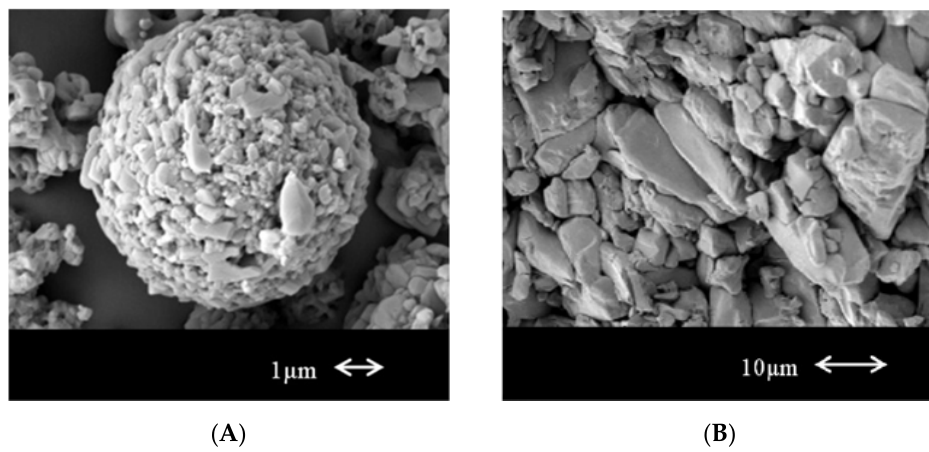
Figure 4. SEM images of spray dried chorothiazide nanocrystalline microparticles ( A ) and raw material ( B ). From reference [35] with permission.